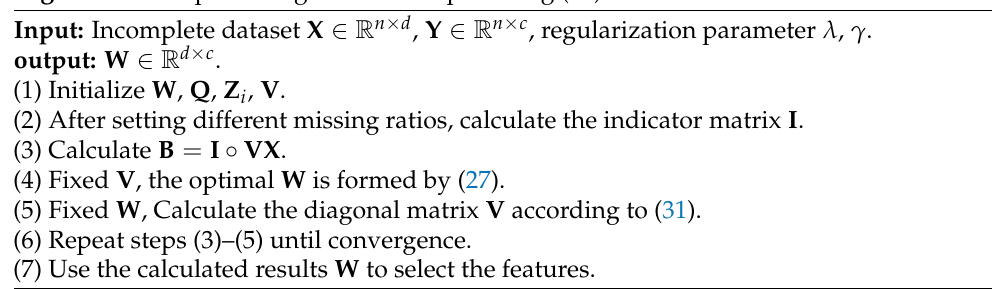
Algorithm 2 Proposed Algorithm for Optimizing